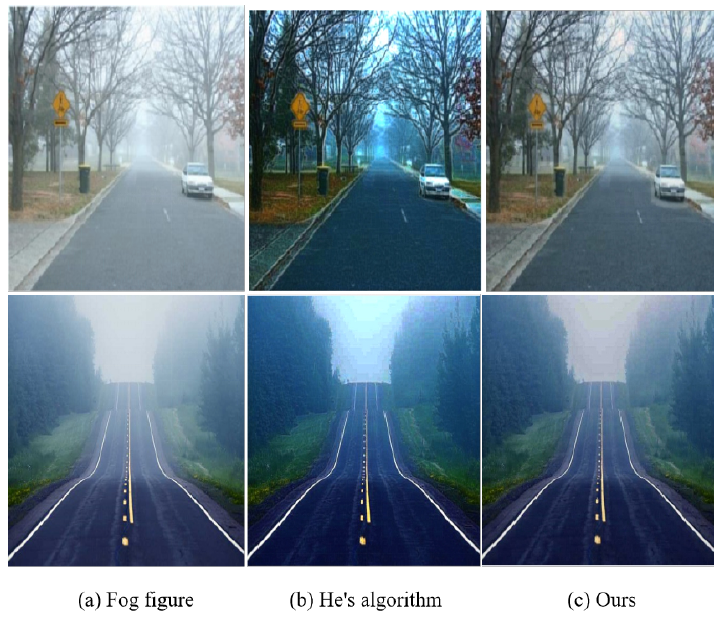
Figure 6. Comparison with He’s algorithms [11] in different